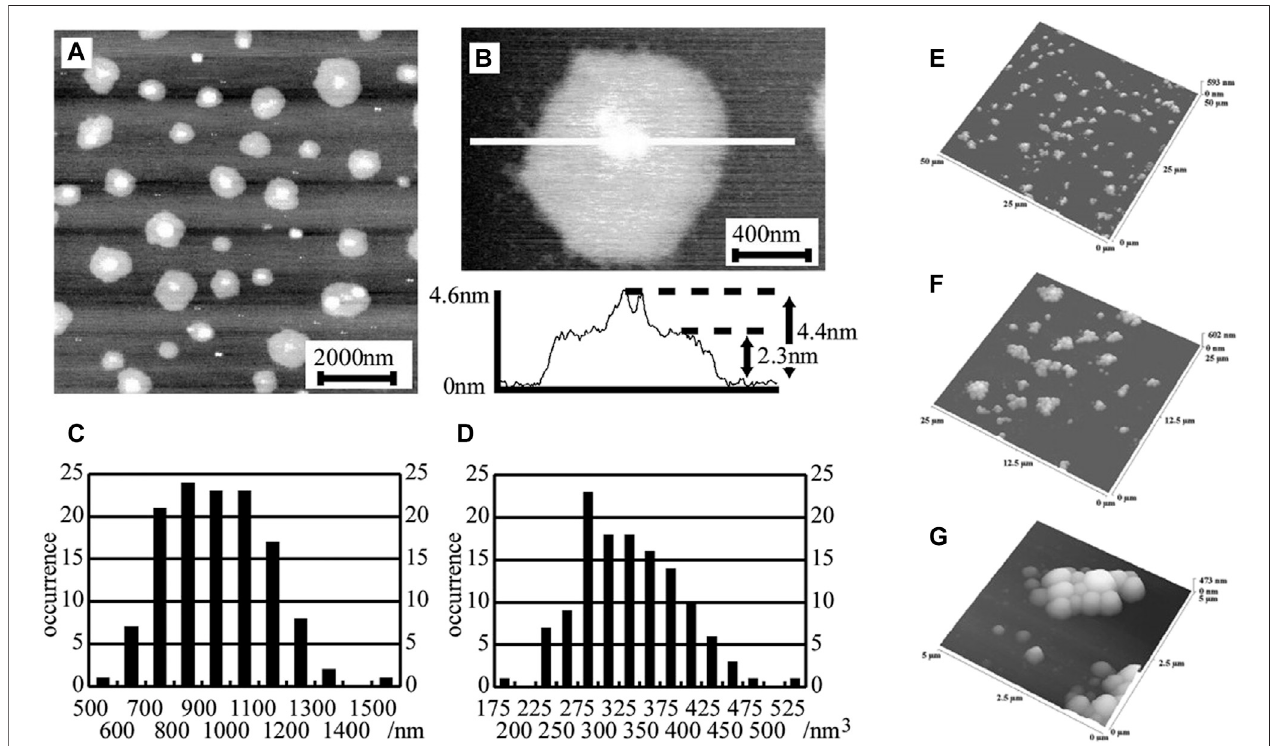
FIGURE3| AFMimagesfortheofHBsAgLparticlesplatedonmicasurfaces. (A) Withscaleof10,000 × 10,000 × 5 nmand (B) withscaleof2,000 × 2,000 × 4 nm. The section analysis of AFM demonstrates a fl attened disc shaped vesicle comprising of a lipid monolayer with height of 1.8 – 2.5 nm. The central white dot represents HBsAgLproteinwithheightof4 – 18 nm. (C) Histogram ofthediametersofthe fl attenedstructuresmeasuredfromAFMimages. (D) Histogramofthesizeofthevesicles calculated from the diameters of the fl attened disc structures (Kanno et al., 2002). (E – G) Non-contact mode AFM images of the SLNs ( β -CD21C6 derived) at scan ranges of (E) 50 μ m, (F) 25 μ m, and (G) 5 μ m (Dubes et al.,